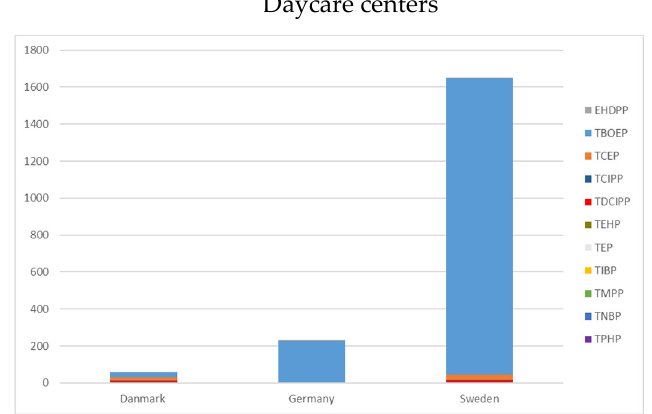
Figure 1. Organophosphorus Flame Retardants (OPFRs) dust median concentration in Europe, 2008–2018 ( μ g/g).